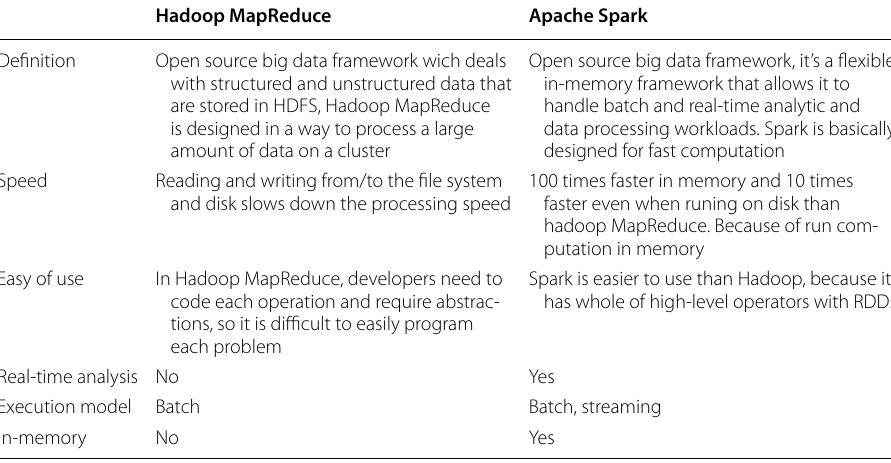
Table 1 Spark and Hadoop MapReduce comparison Hadoop MapReduce Apache Spark